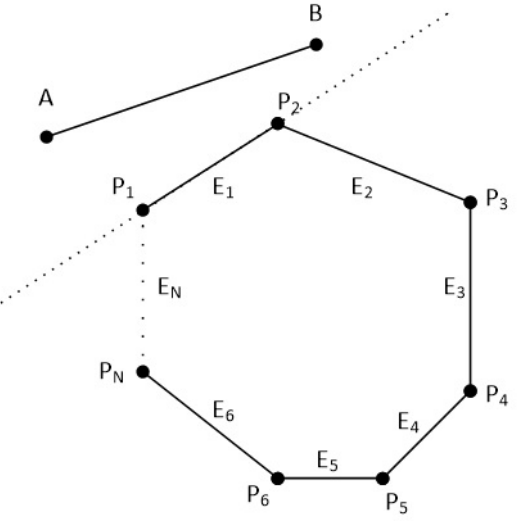
Figure 40. If points A and B are on the left side of an edge then the line is completely